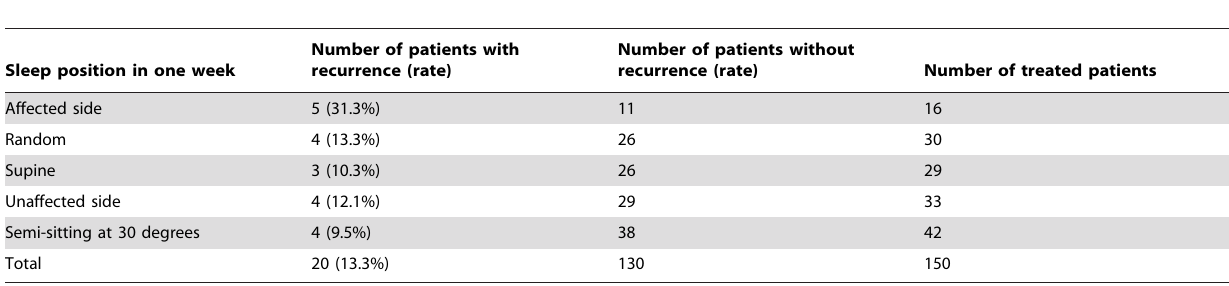
Table 2. The comparison of recurrence rates in patients who slept in different positions during the first week after the repositioning